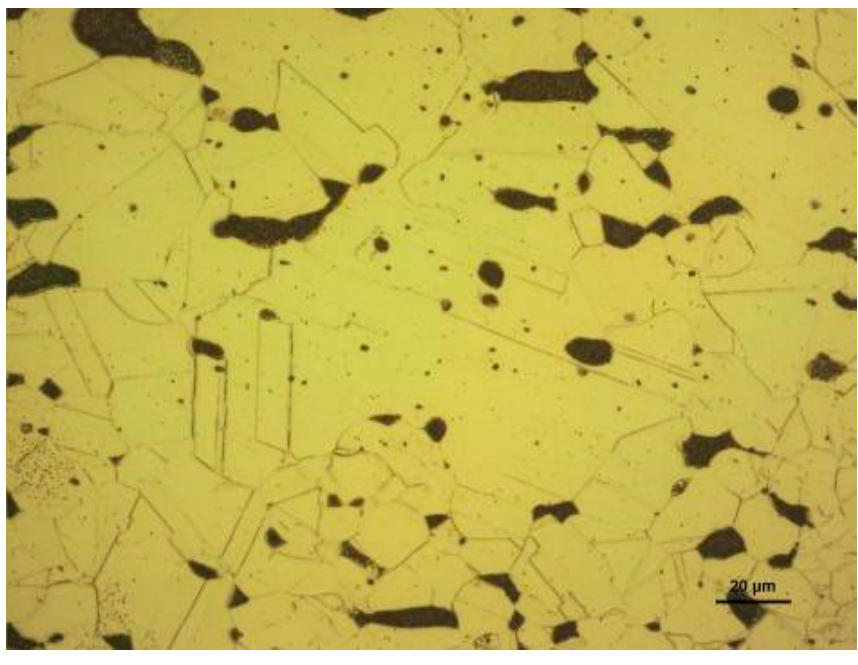
Figure 13. Microstructure of the cage.